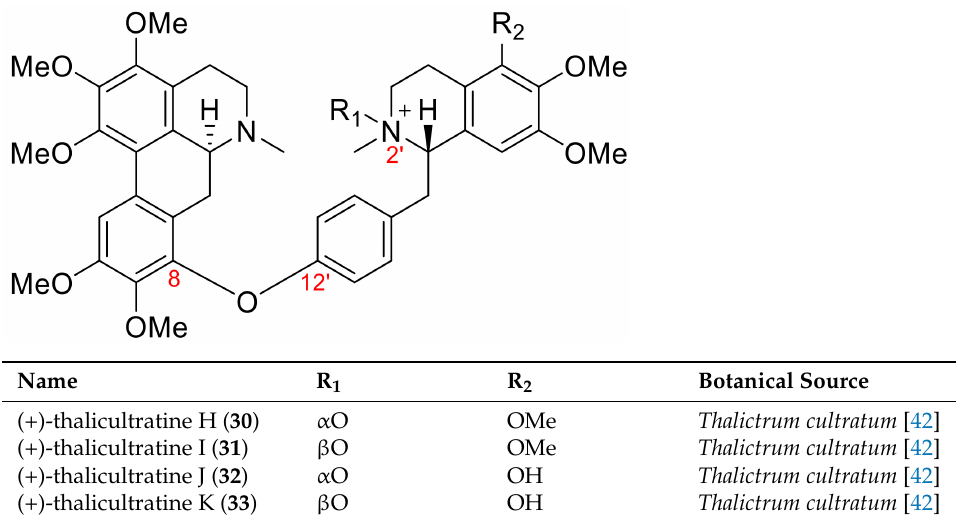
Figure 3. Structures of acutiaporberine ( 5 ), thaliculine ( 6 ), and 6a,7-dehydrothaliculine ( 7 ). Table 3. 2 (cid:48) - N -oxide aporphine–benzylisoquinoline dimeric alkaloids of the thalifaberine